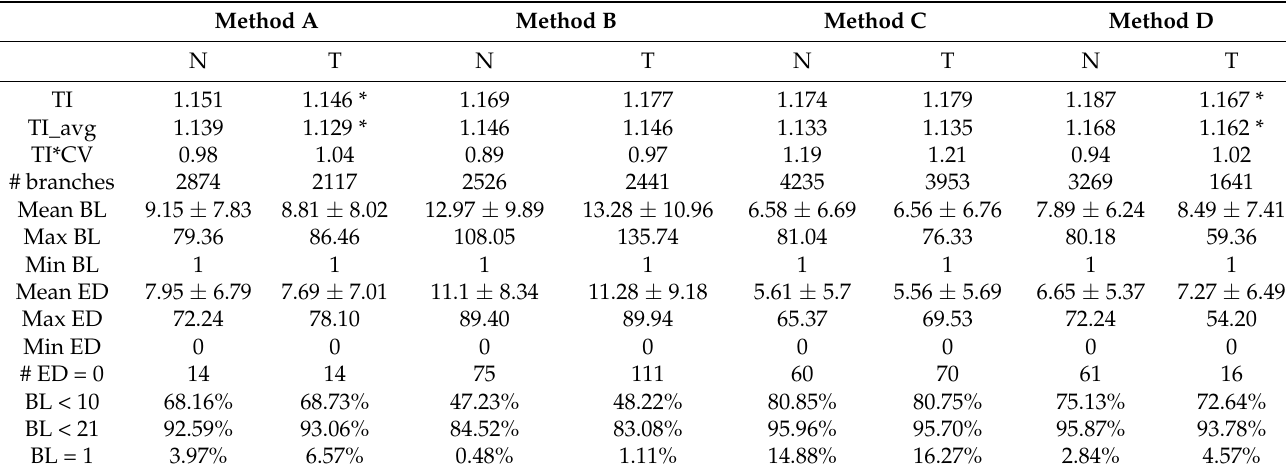
Table 1. Tortuosity indexes and branch-related features of the two exemplificative OCT images, calculated by means of the four investigated